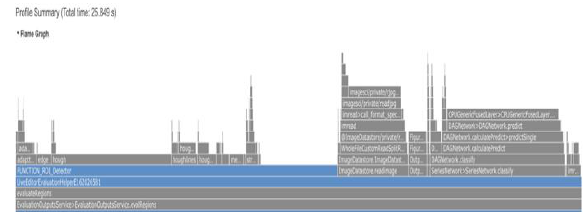
Figure 18. Training data image improved segmentation by ROI_RESIZED detector